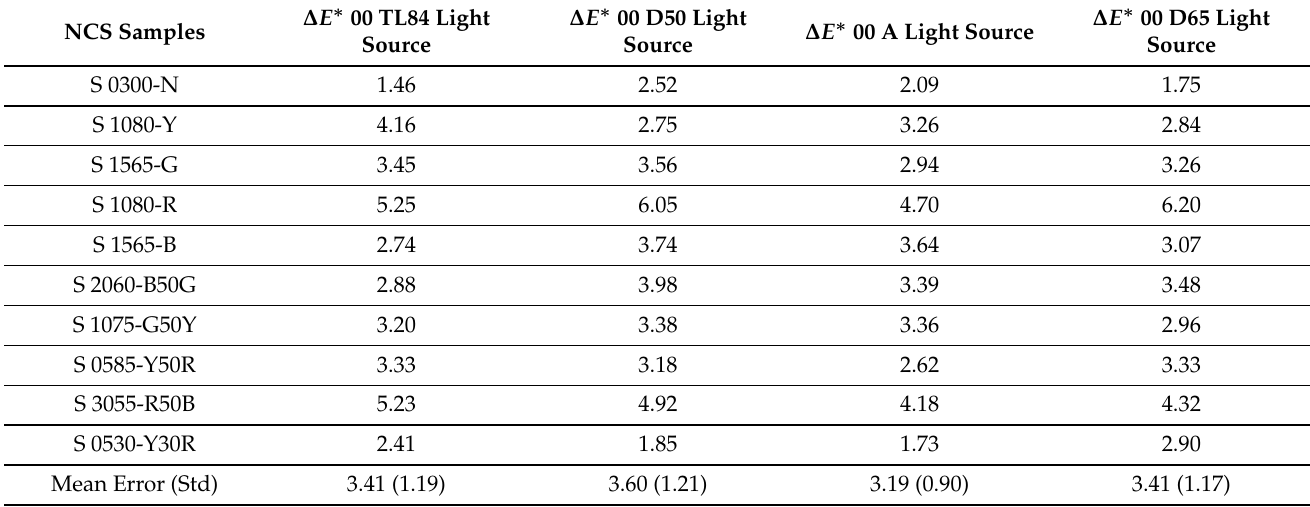
Table 1. Color difference between real and virtual NCS samples under different light